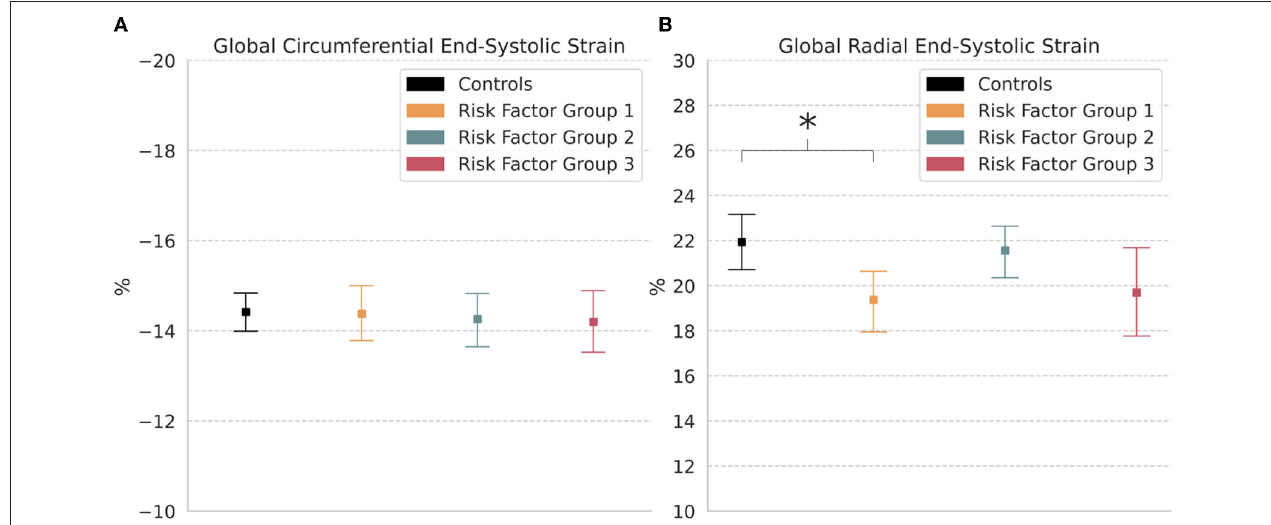
FIGURE 3 | Global strain. Measures of (A) Circumferential and (B) Radial end-systolic strain in controls and risk factor groups. Strain results are visualized as mean with 95% confidence interval. post-hoc test by Bonferroni: * p < 0.05.